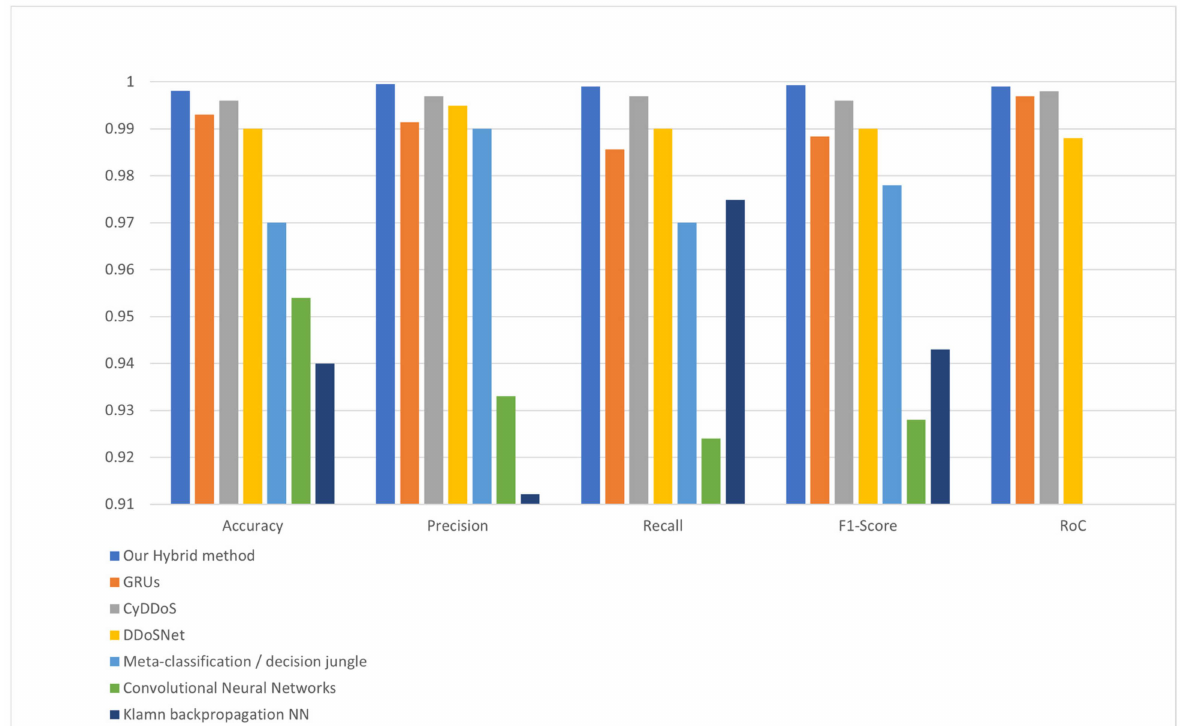
Figure 15. Comparison with other